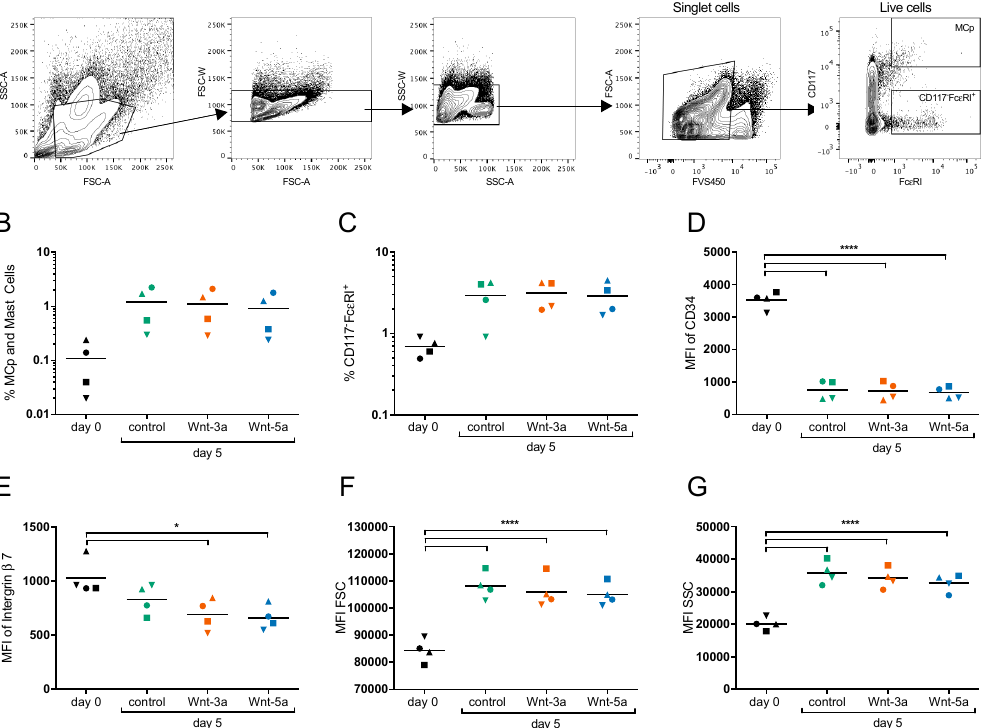
Figure 2. Stimulation with purified recombinant Wnt-3a and Wnt-5a did not influence early mast cell progenitor development. CD34 + cells were enriched from buffy coats and cultured for five days with or without 100 ng / mL Wnt-3a or Wnt-5a under conditions that promote mast cell development. The cells were gated for single cells / live cells, and mast cells / mast cell progenitors (MCps) were gated as CD117 high Fc ε RI + and CD117 − Fc ε RI + for basophils ( A ). Frequencies of early mast cells and mast cell progenitors ( B ). Frequency of CD117 − Fc ε RI + ( C ). CD34 expression ( D ), Integrin β 7 expression ( E ), FSC ( F ) and SSC ( G ) for the gated mast cell progenitors / early mast cells. n = 4; each symbol represents an individual culture. * p < 0.05; **** p <